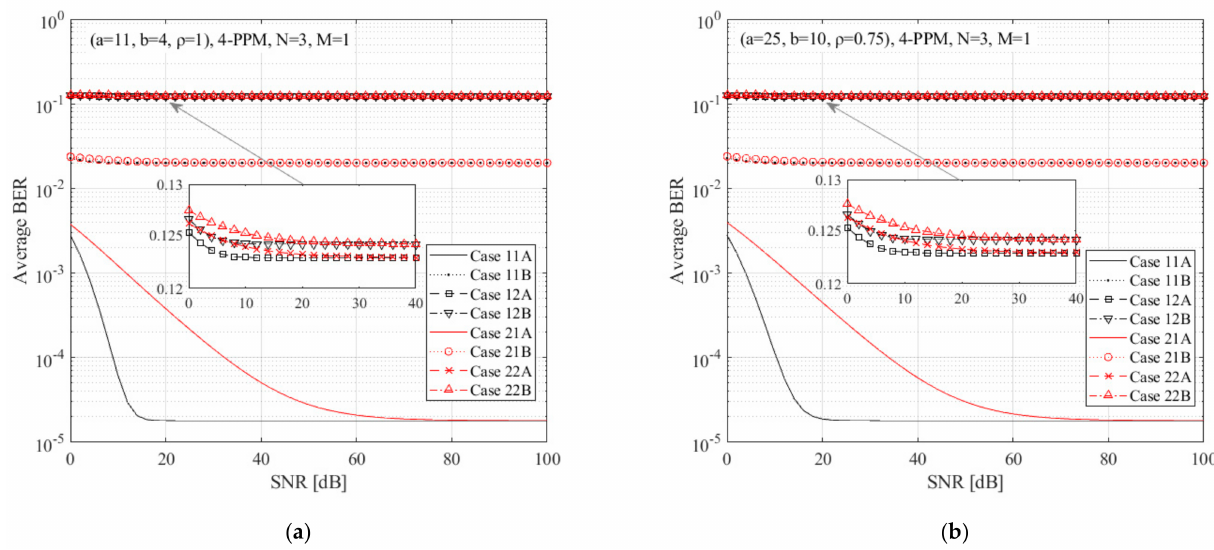
Figure 3. ABER versus expected SNR for the 4-PPM scheme, N = 3, M = 1, with various bit rates and spatial and time jitter conditions of ( a ) ( a = 11, b = 4, ρ = 1) and ( b ) ( a = 25, b = 10, ρ = 0.75). The studied curve cases are codified as in Figure 2.